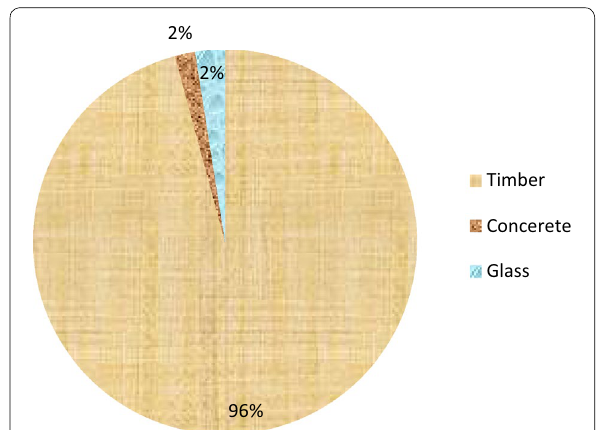
Fig. 7 Source of construction